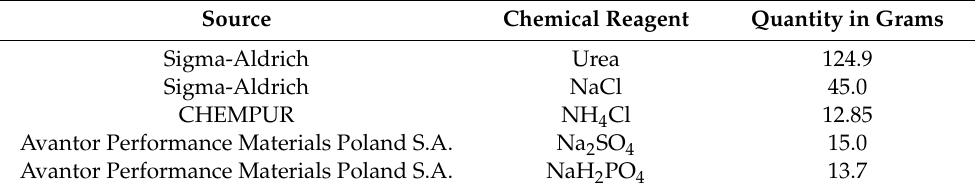
Table 1. Components of artificial urine with the amount needed to prepare 1 L of solution.